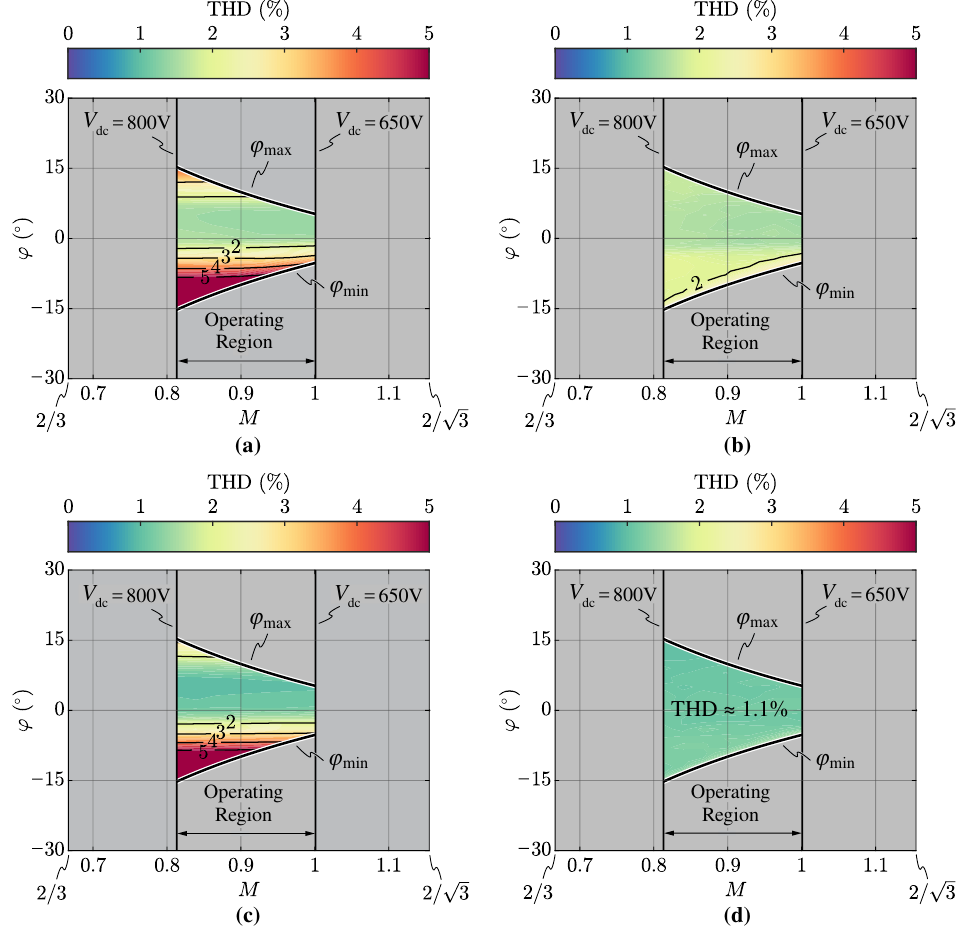
Figure 19. Experimental grid-side current total harmonic distortion (THD) for S = 15kVA ( a , b ) and S = 30kVA ( c , d ). Results without zero-sequence voltage saturation ( a , c ) and with zero-sequence voltage saturation ( b , d